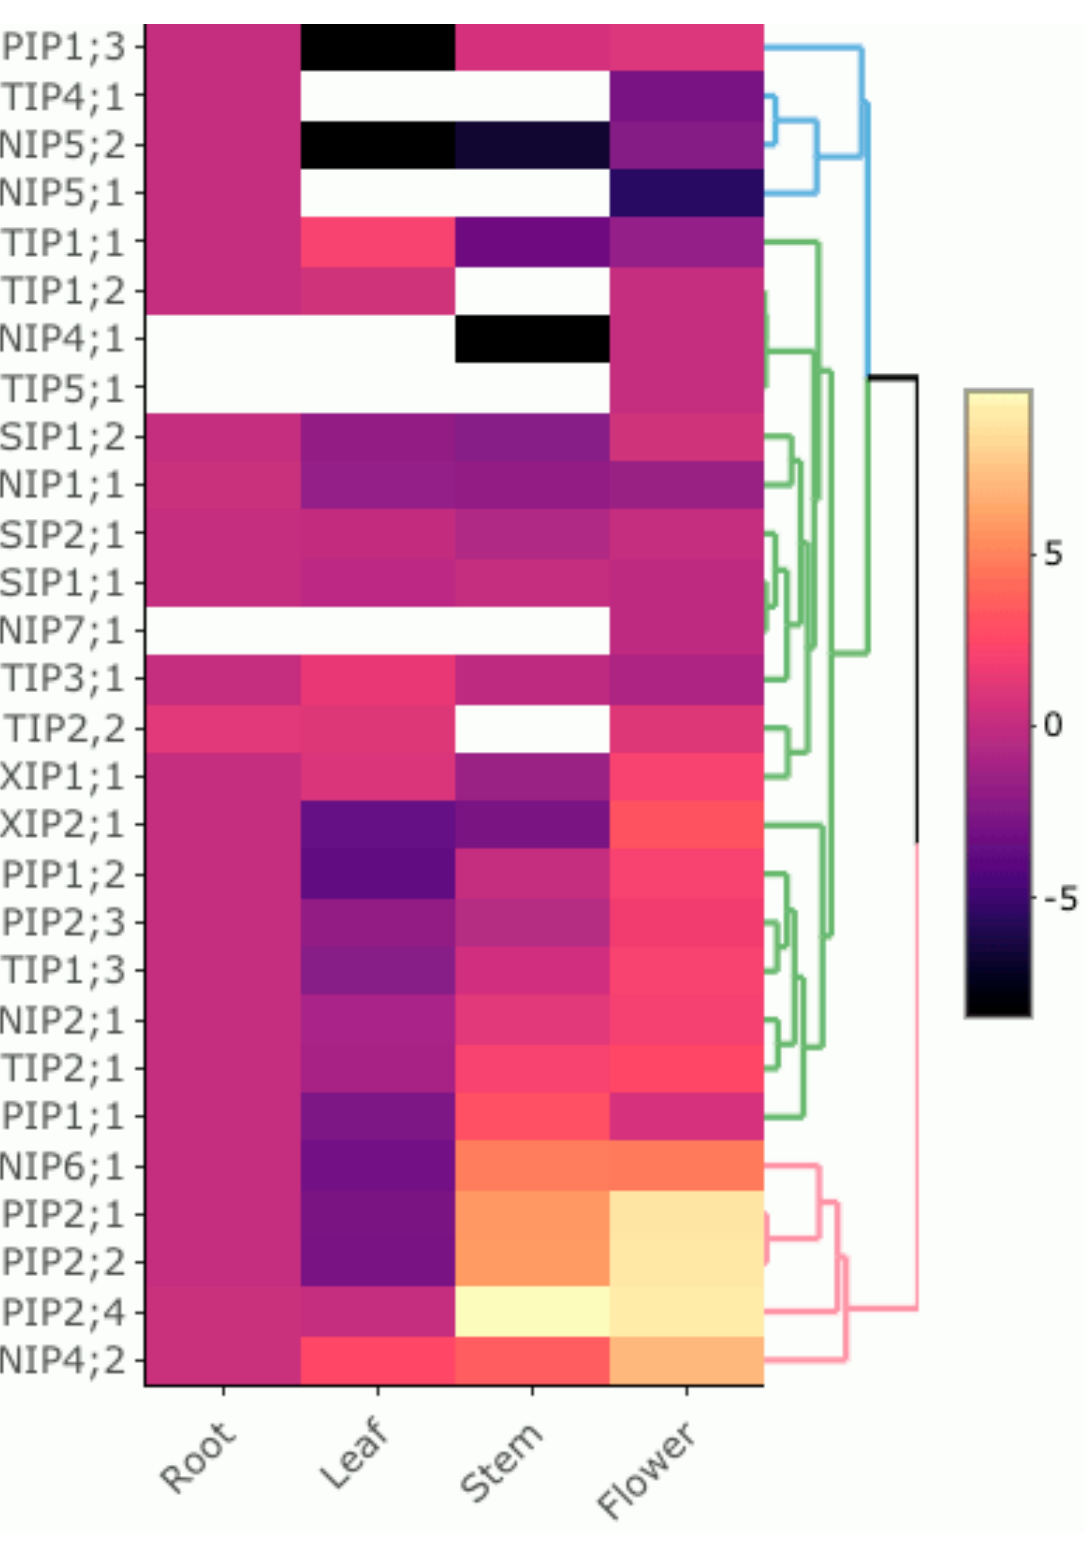
Figure 5. Heatmap and hierarchical clustering of the expression profiles of all AQP genes in different cherry tissues. The expression abundance of each transcript (log2 of qPCR analysis fold-change values, three biological and two technical replicates) is represented by a color range from yellow (higher expression) to black (lower expression). White: not detected at transcript levels. For each AQP gene, transcript levels were calculated using its mRNA abundance detected in roots as reference for the rest of the